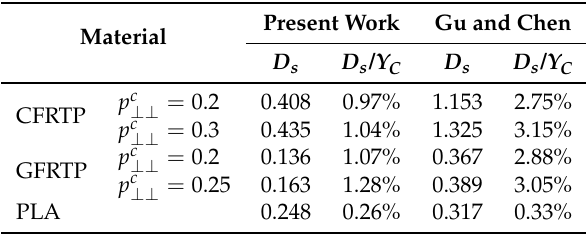
Table 9. Polyline distances (from Original Puck and Schürmann) computed for 3D-printed materials.